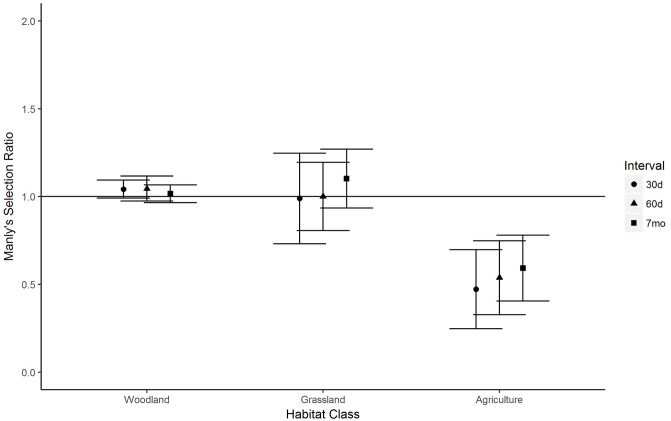
Habitat selection by female white-tailed deer fawns over intervals of 0–30 days post-capture, 0–60 days post-capture, and 0 days–7 months post-capture, Boone County, Iowa, USA, 2015–2017.Selection ratios >1 indicate selection for a habitat class, while ratios <1 indicate selection against a habitat class. Error bars represent 95% confidence intervals.